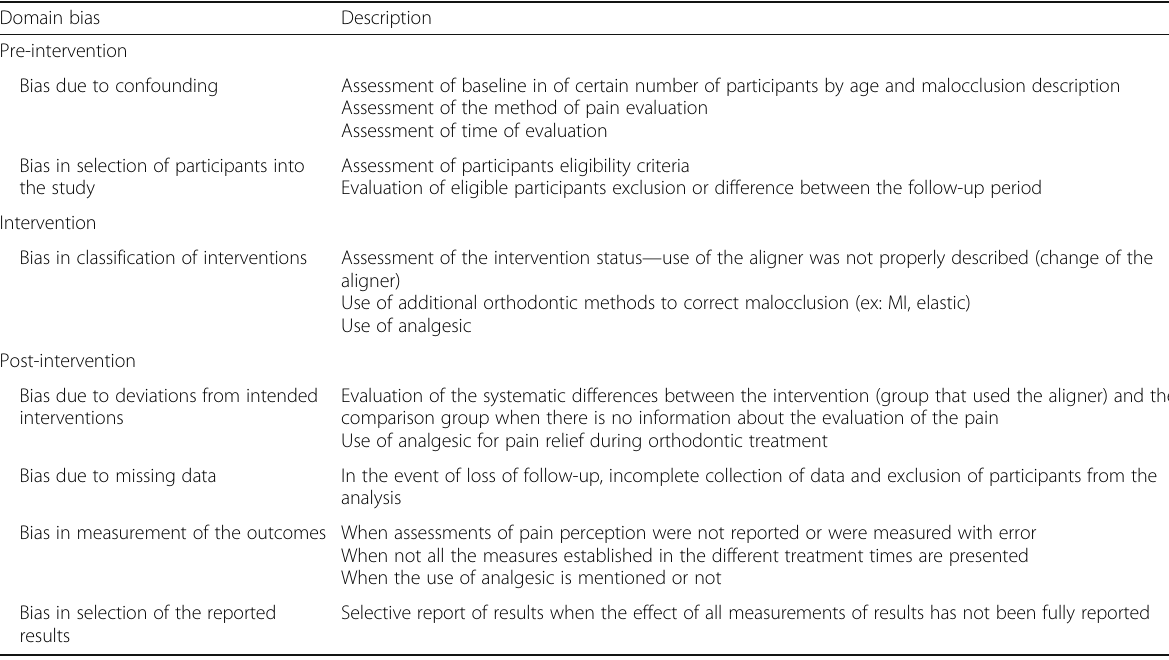
Table 3 Risk of bias of included